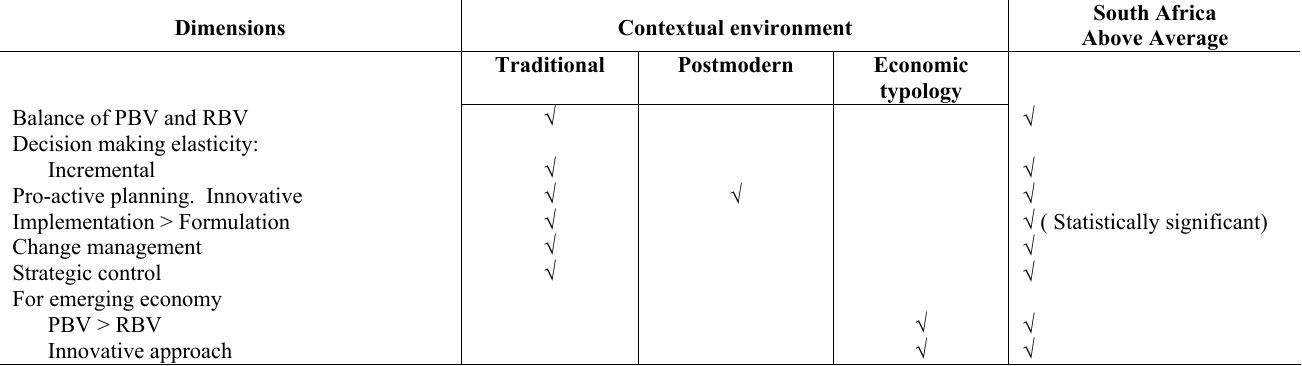
Table 2: Comparison of South African organisations with a global best practices framework